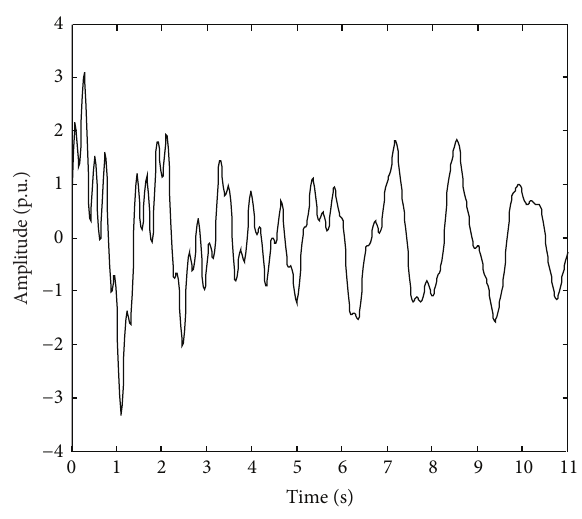
Figure 2: Synthetic